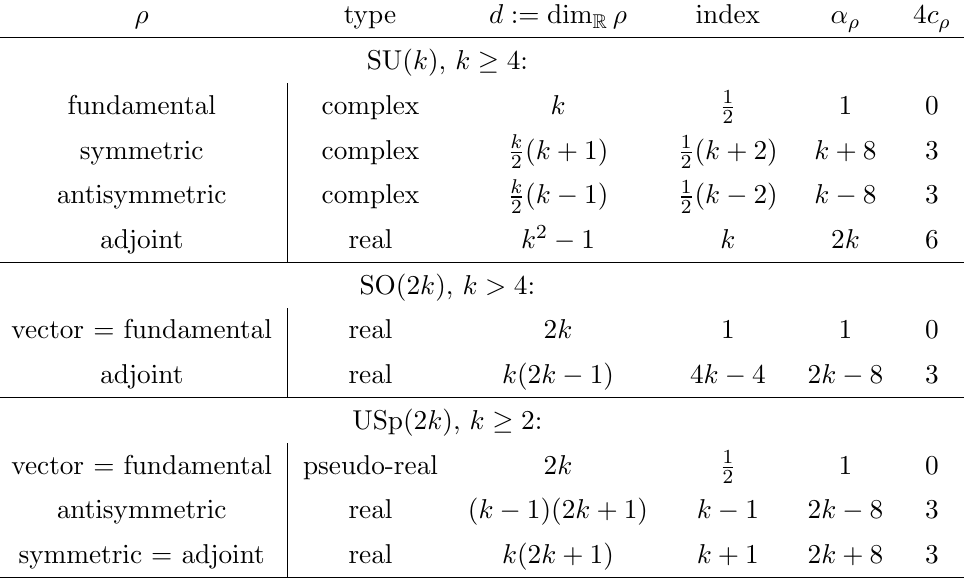
= 4 c here (cid:26) (cid:26)